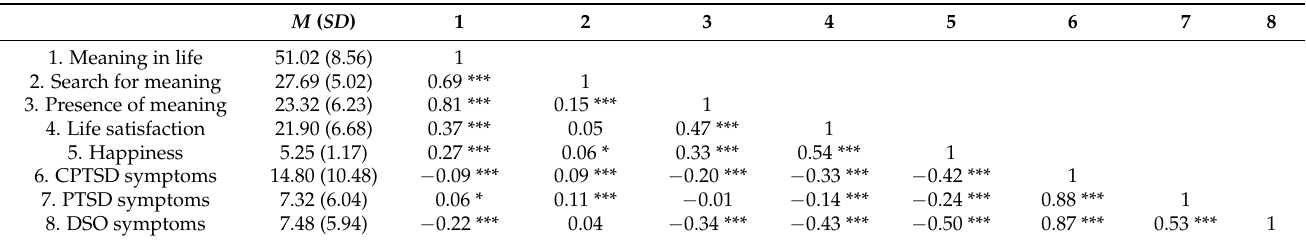
Table 2. Descriptive statistics and correlations among meaning in life, life satisfaction, happiness, and three symptoms ( n = 1451).